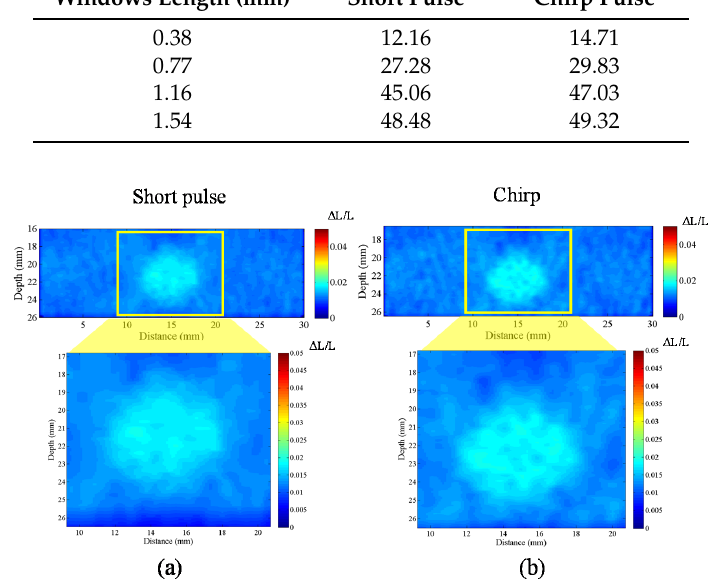
Figure 22. Strain images for two pulse. ( a ) The window length is 1 mm for short pulse, and the SNRe of the background and target is 15.99 and 19.69, respectively; and ( b ) the window length is 0.77 mm for chirp pulse, and the SNRe of the background and target is 16.03 and 20.12, respectively.